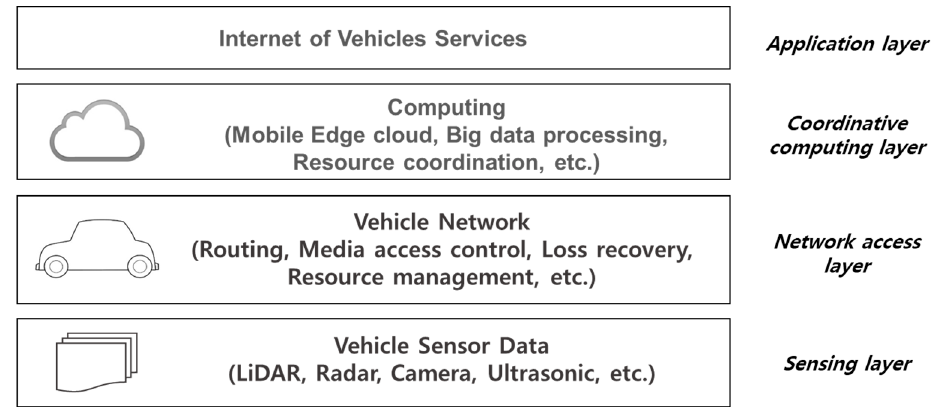
Figure 2. IoV system architecture [20].